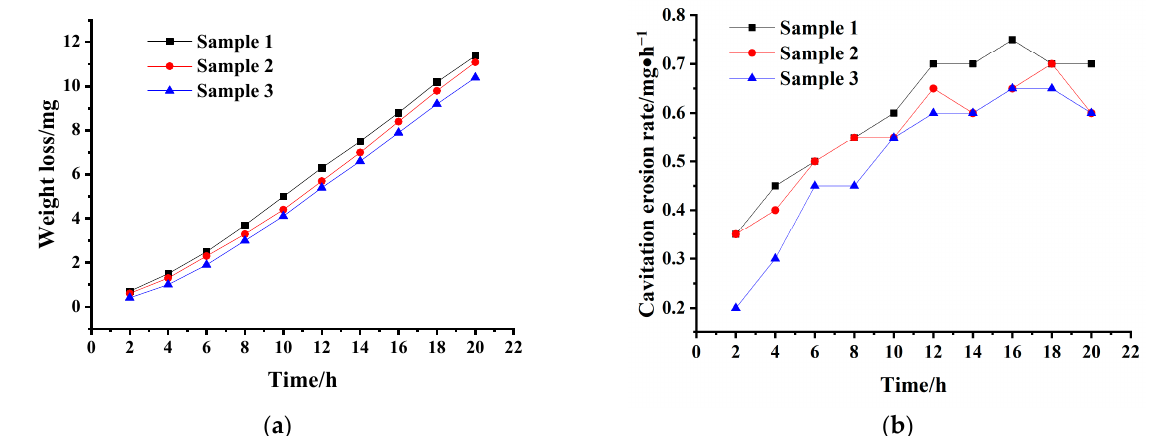
Figure 7. ( a ) The cumulative weight loss curves of brass samples with increasing acting time. ( b ) Curves of the cavitation erosion of brass samples with increasing action time.